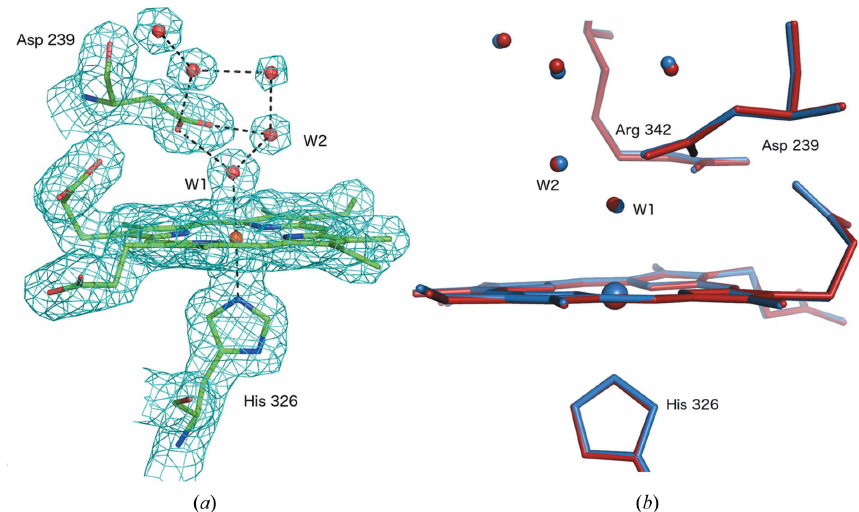
Figure 2 ( a ) 2 F o – F c electron-density map contoured at 1 (cid:5) for the damage-free SFX structure of DtpAa at 1.88 A˚ resolution, showing the clear and well resolved water network within the heme pocket. Water molecules interact extensively with the pocket residue Asp239 as well as with Arg369 (omitted for clarity). ( b ) Superposition of the SFX structure (blue) with the 32.8 kGy SSX structure (red). Small changes to the heme-pocket water network are apparent even at this low